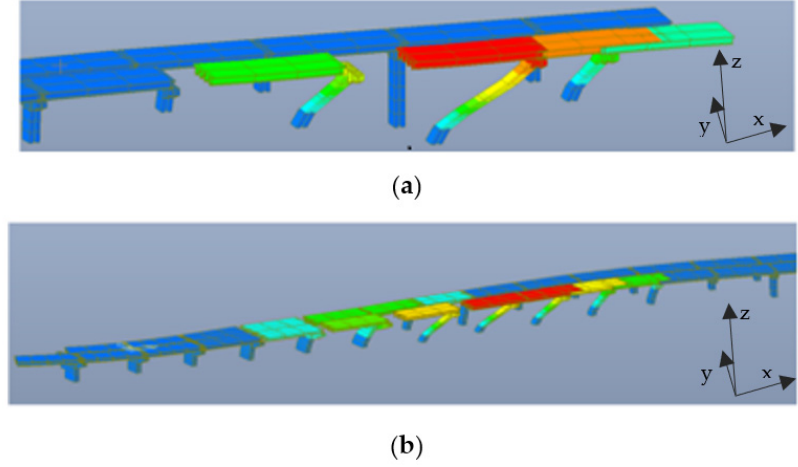
Figure 12. ( a ) First mode X-direction (pile 14S). ( b ) Second mode X-direction (south piles of the central sector of the bridge).